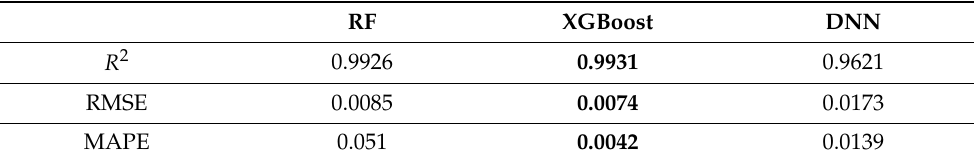
Table 6. Statistical measures for different ML-based regression models tested against the blind dataset provided for Oldroyd-B fluids.